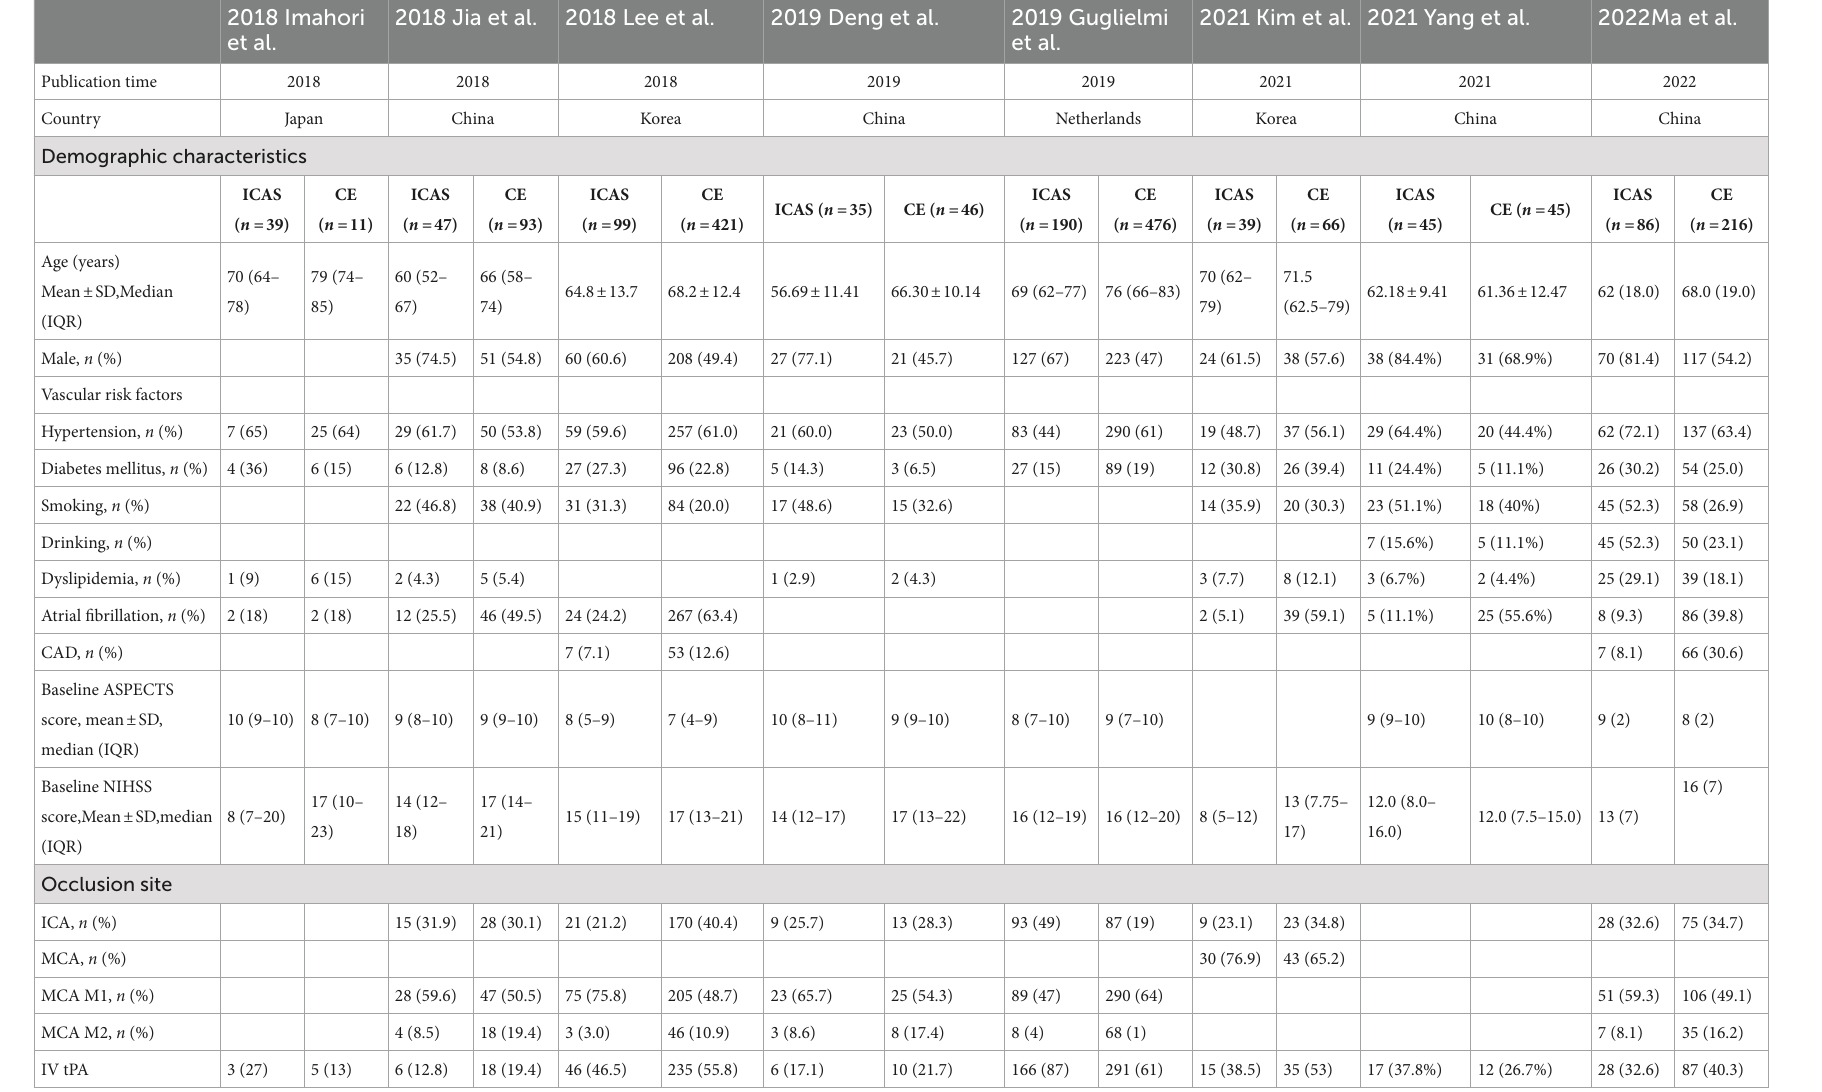
TABLE 4 Baseline characteristics of patients in